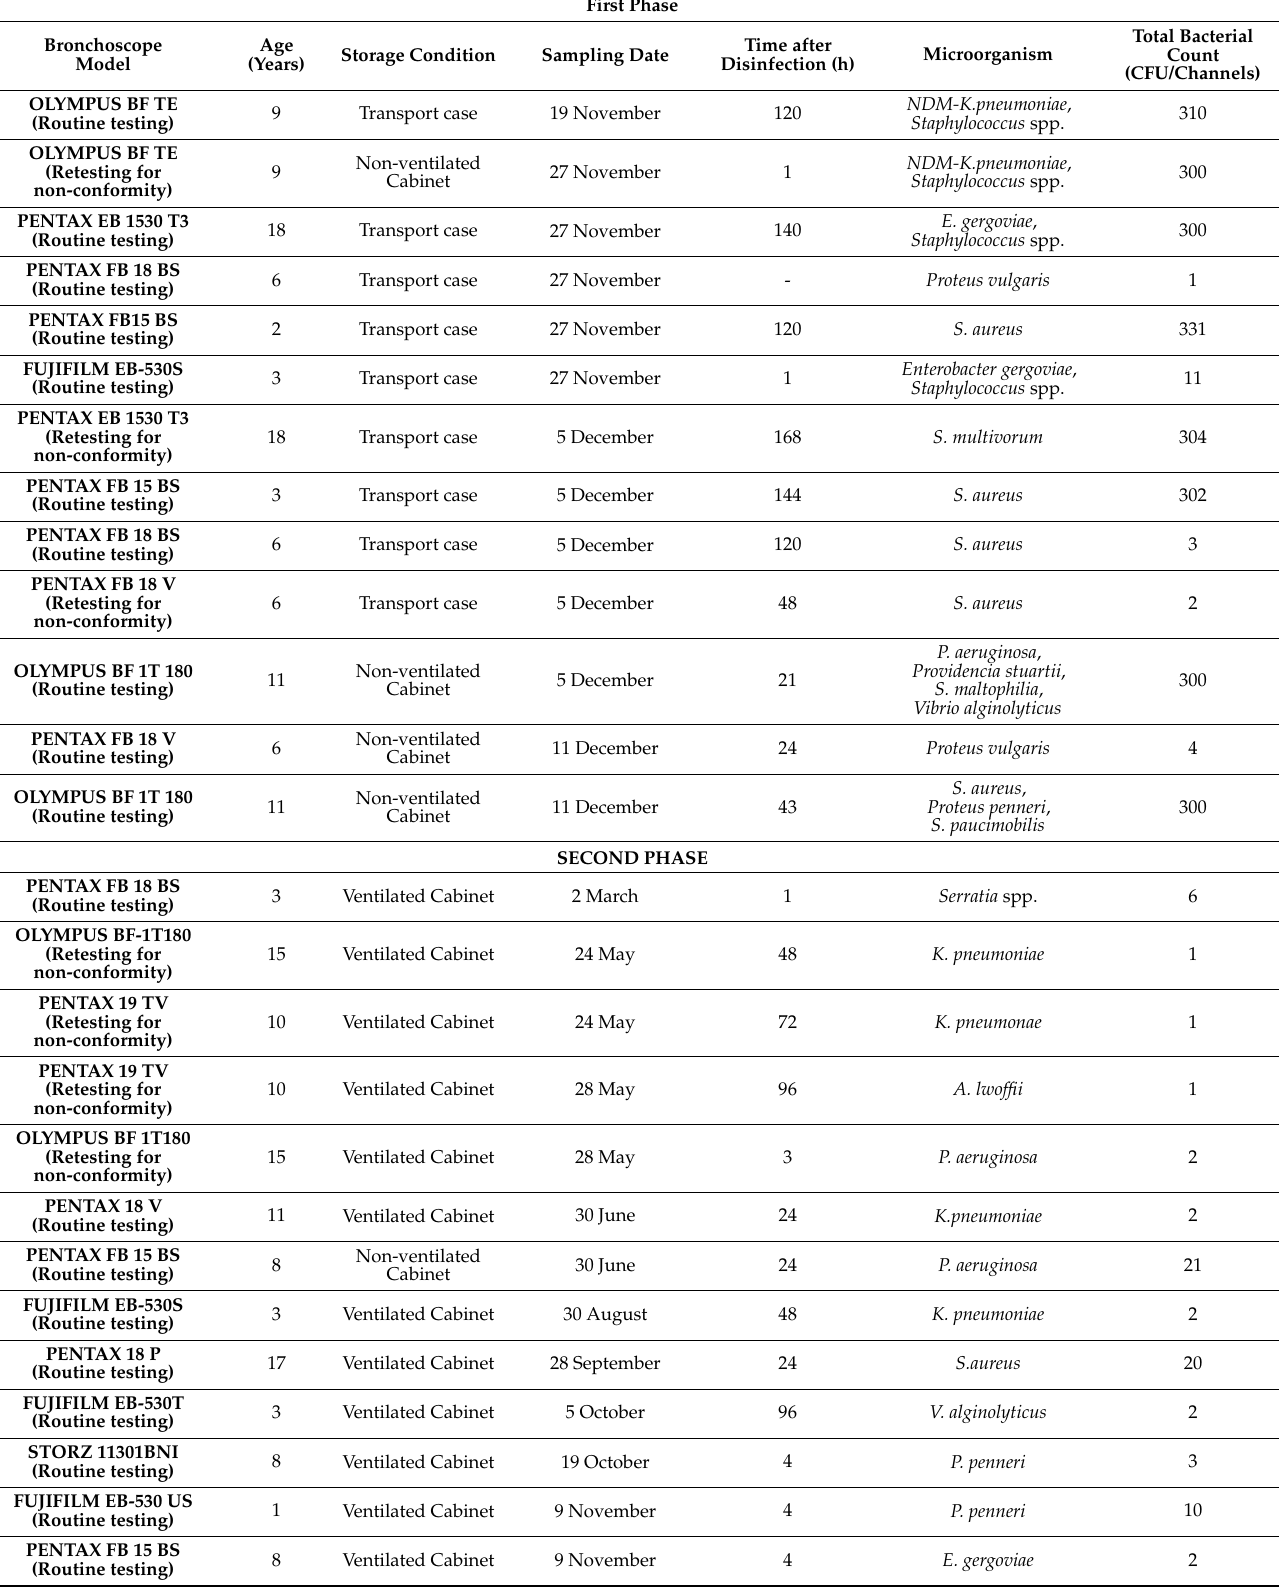
Table 2. Bronchoscope model, age, storage condition, and high-concern organisms identified during the microbiological surveillance conducted in the first and second phase of the study,